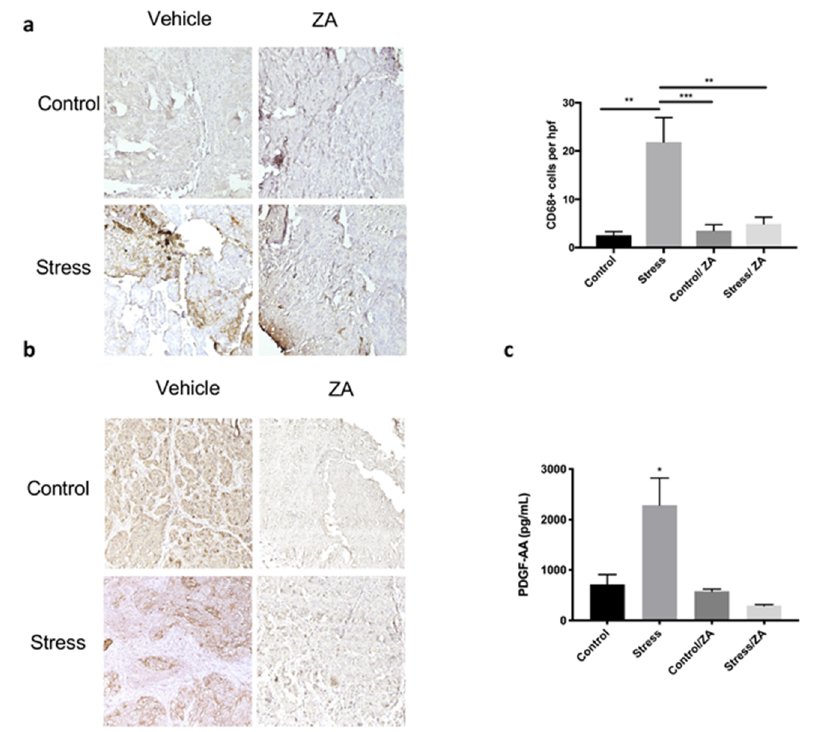
Figure 6. Zoledronic acid (ZA) prevents stress-induced macrophage infiltration and reduces intratumoral PDGF-AA expression in an orthotopic mouse model. Immunohistochemical analysis of SKOV3ip1 tumor samples from mice subjected to restraint stress and ZA showing expression of ( a ) CD68 + and ( b ) PDGF-AA. 20 × magnification. ( c ) PDGF-AA protein expression in SKOV3ip1 tumor samples. Mean ± SEM. * p < 0.05 ** p < 0.01 *** p < 0.0001.